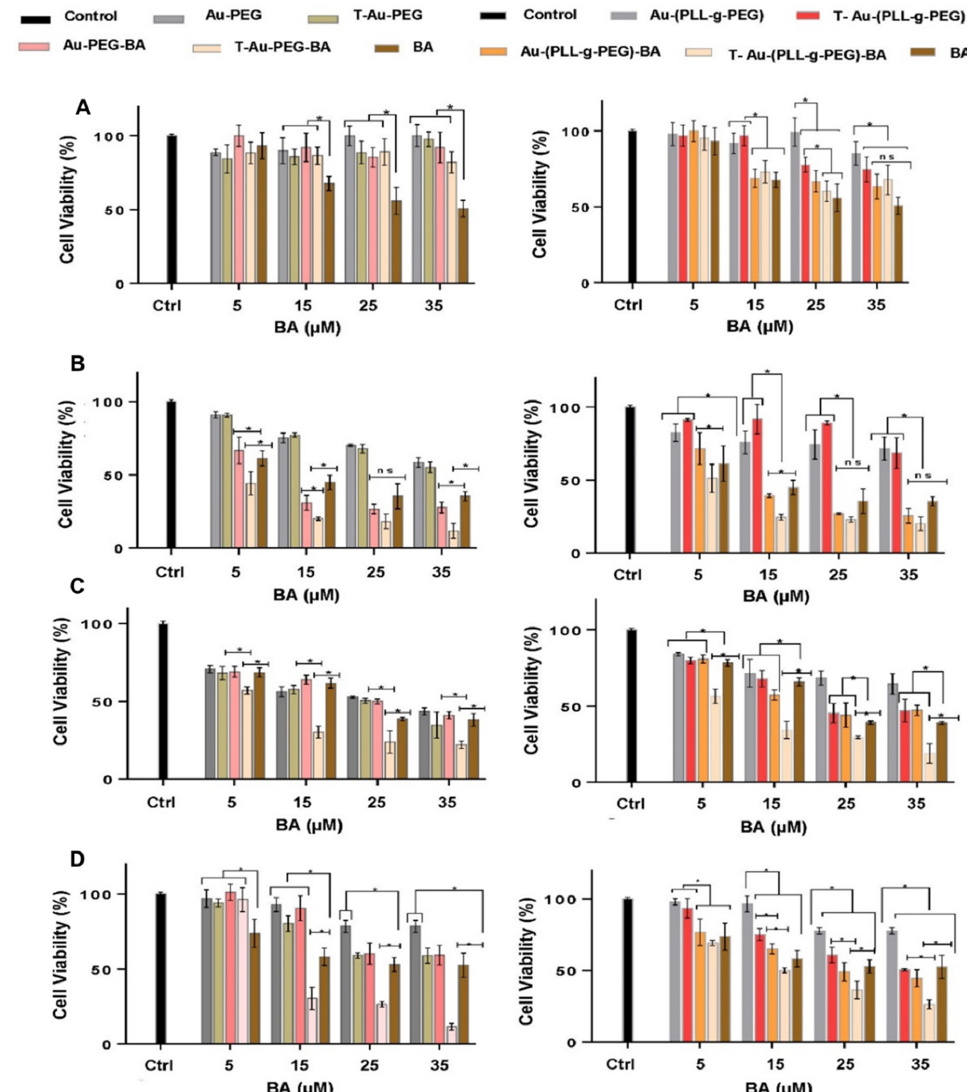
Figure 7. Effect of nanoparticles and drug nanocomplexes on cell viability in ( A ) HEK 293, ( B ) Caco-2, ( C ) HeLa and ( D ) MCF-7 cells. Au-PEG-BA; Au-[PLL-g-PEG]-BA = untargeted nanocomplexes, T-Au- PEG-BA; T-Au-[PLL-g-PEG]-BA = targeted nanocomplexes, and BA= free drug. Data is represented as mean ± SD ( n = 3); * p < 0.05); ns = no significant